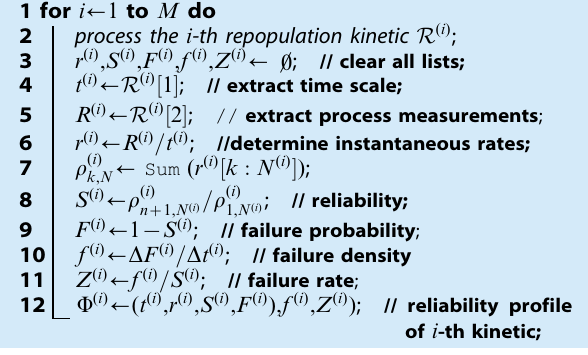
Algorithm 1. Algorithm for calculating the discrete time series of reliabilities failure probabilities failure densities and failure rates for batches of raw kinetics. Numbers to the left of the listing indicate line numbers. These are used to reference particular computations in the main narrative. The general notation X ½ k : w (cid:2) denotes the elements X ½ k (cid:2) through X ½ w (cid:2) of a list X . The symbol D denotes the successive differences operator defined for a list of length